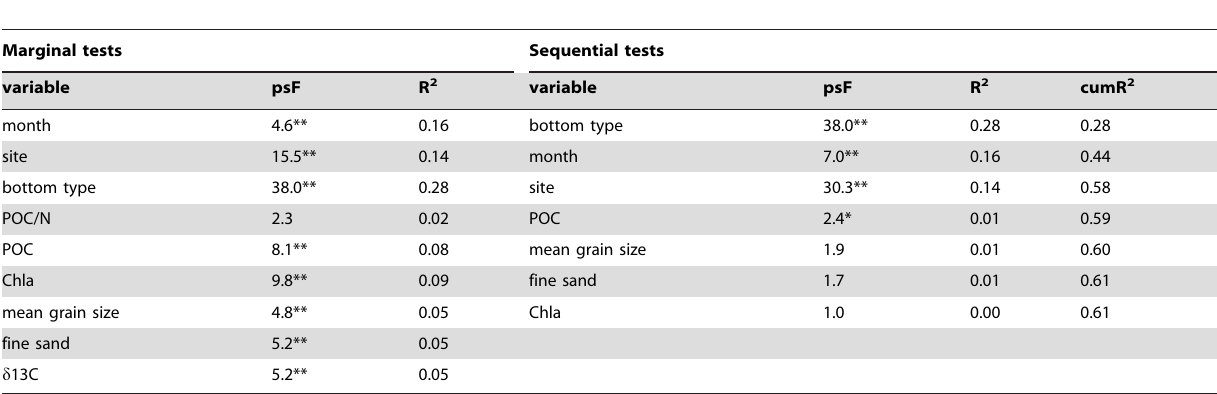
Table 3. Results of DISTLM procedure for fitting environmental variables to macrobenthic composition.